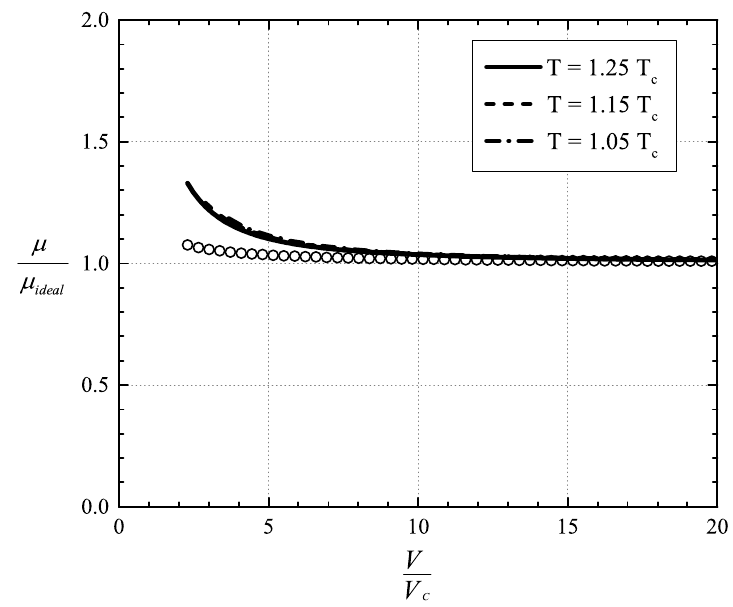
Figure 5. Scaled shear viscosity vs. V / V c at temperatures = 1.25 T c , 1.15 T c , and 1.05 T c . The lines denote the exact viscosity resulting from the viscosity model of Chung et al. [28,29]. The symbol (cid:13) denotes the virial expansion of viscosity computed using Equations (69) and (70).